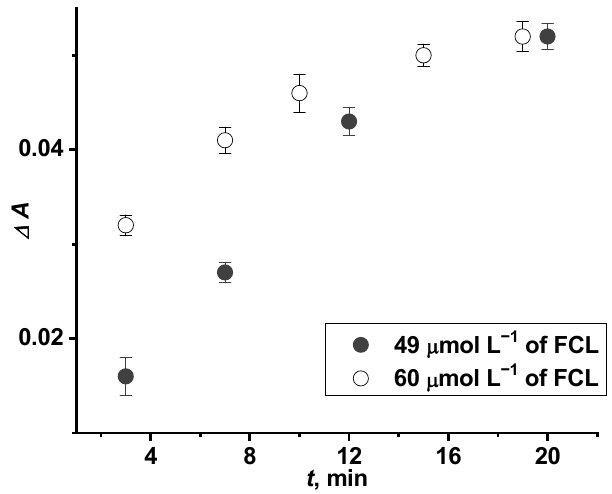
Figure 9. Dependence of change in absorption maximum ( Δ A ) measured after the addition of FCL into PBS on time. Filled circles: Δ A measured after adding 49 μ mol L − 1 of FCL into PBS; hollow circles: Δ A measured after adding 60 μ mol L − 1 of FCL into PBS.